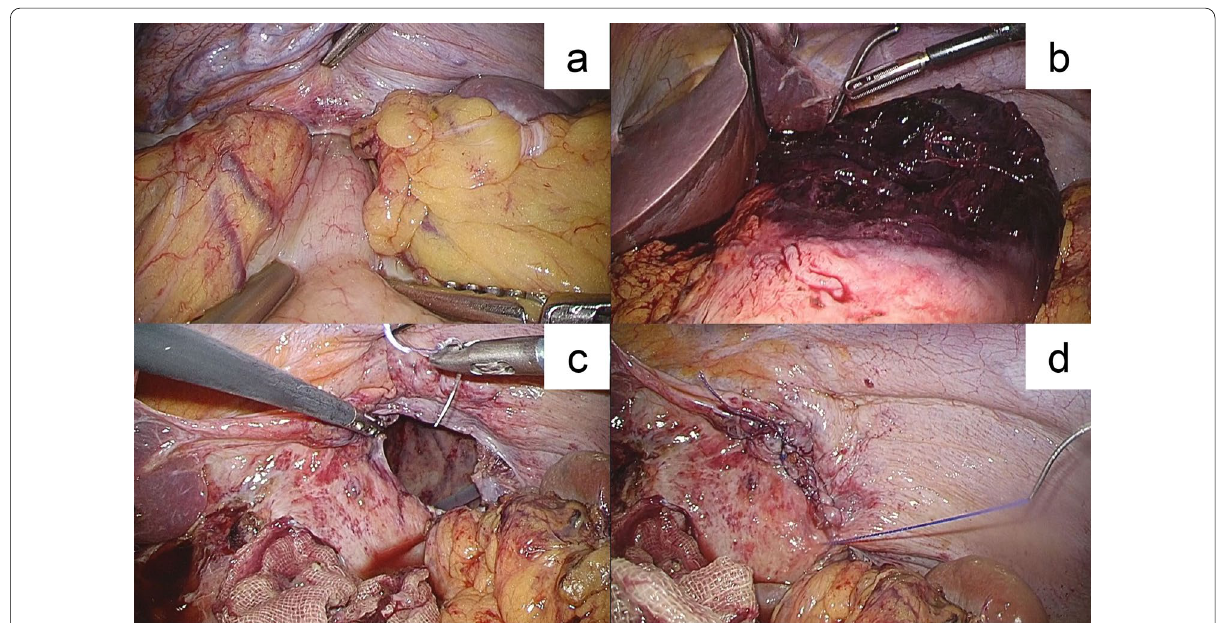
Fig. 2 Surgical findings. a Precise exploration of the abdominal cavity and diaphragm revealed that the stomach incarcerated into the left thoracic cavity through a hernial defect in the left hemidiaphragm. The intraperitoneal body of the stomach was viable. b The herniated body was pulled back to the abdominal cavity after hernia orifice enlargement and gastric content aspiration. The fundus and corpus of the stomach were necrotic. c The hernia defect before closure was estimated to be 4 cm in the major axis after incision. The thoracic cavity could be observed and were drained through the defect. d The hernial defect was completely closed using a nonabsorbable running suture